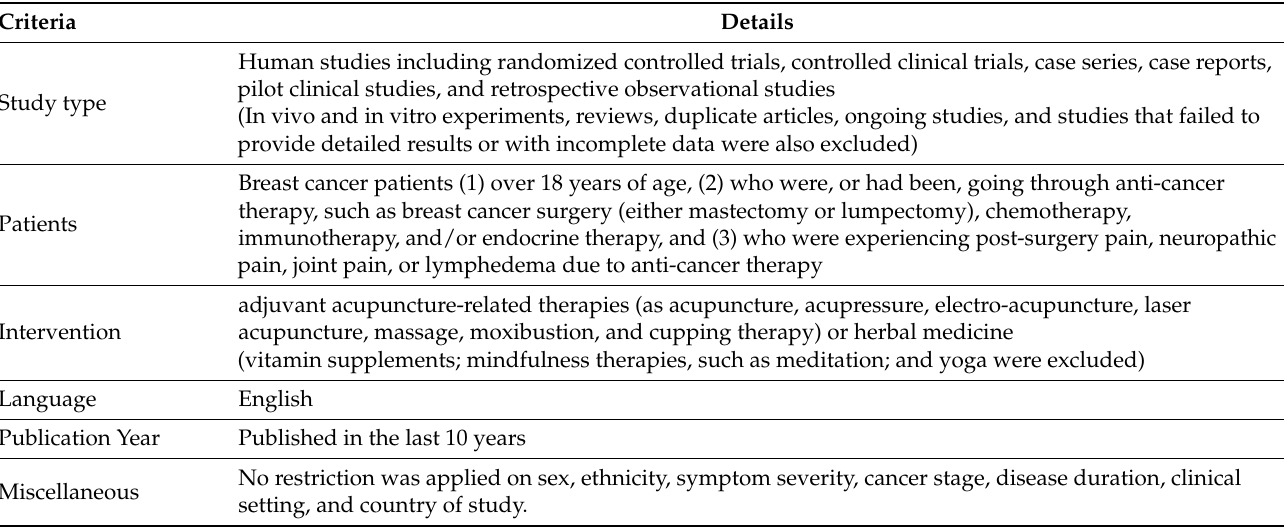
Table 2. The selection criteria of studies for this scoping